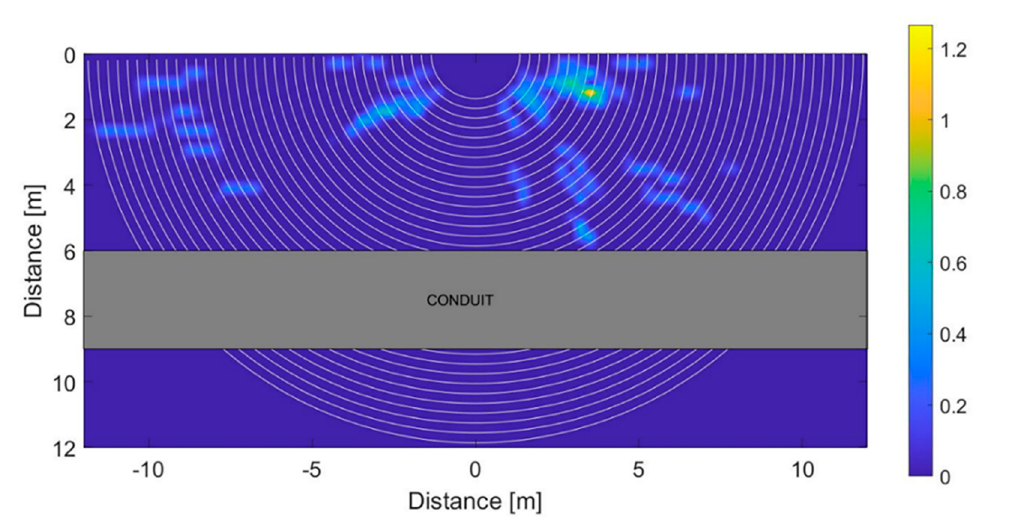
Figure 15. Root mass density map from 0.60 m to 0.70 m.